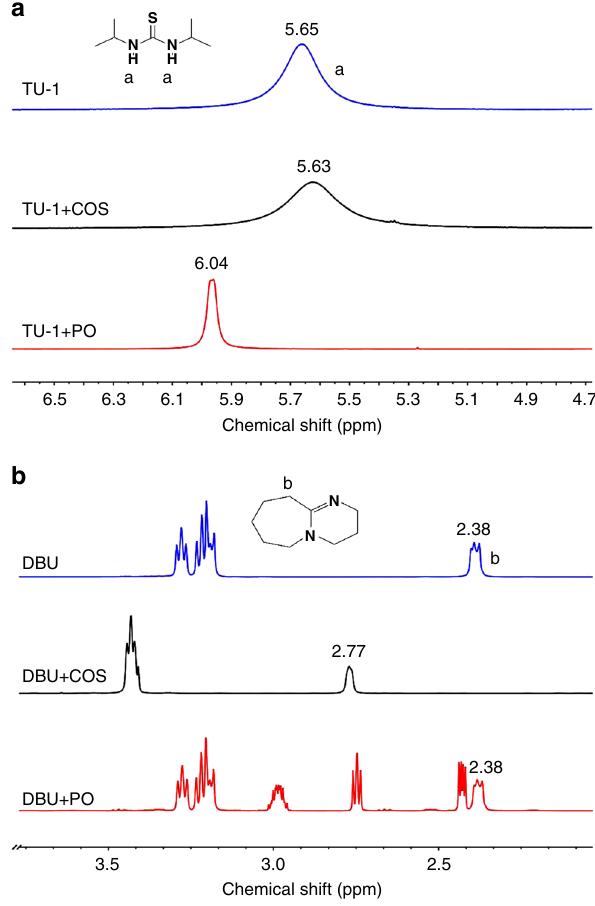
Fig. 5 The speci fi c recognition of TU-1 to PO and DBU to COS in TU-1/DBU pair via hydrogen-bonding interaction. a 1 H NMR spectra of TU-1,